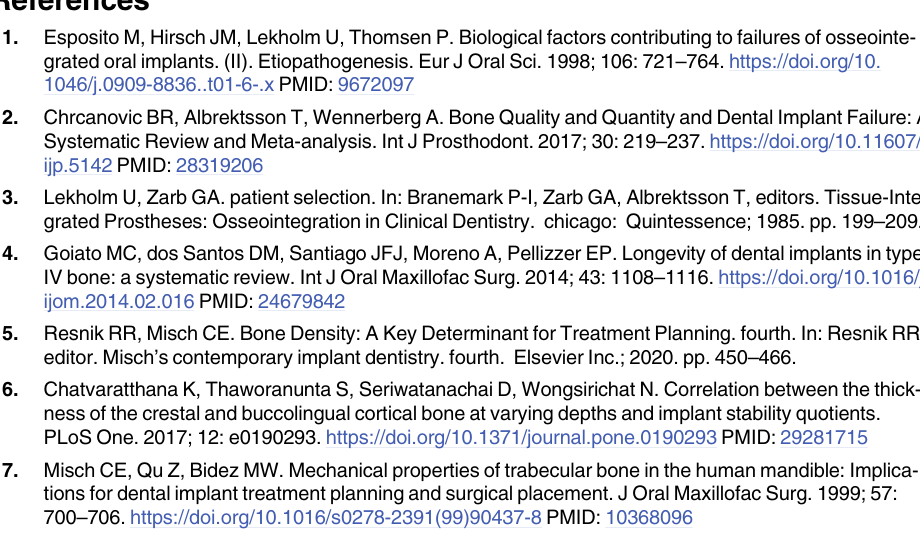
S1 Table. Search strategy keywords specific for the study question. S2 Table. General characteristics of the included